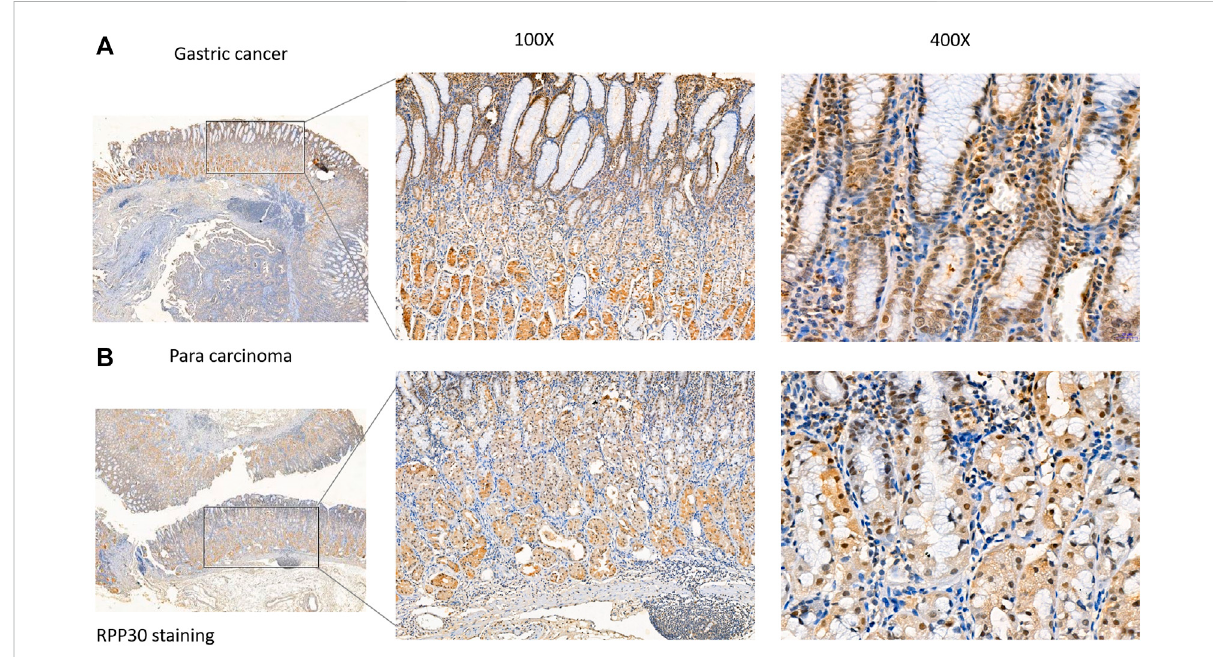
FIGURE 8 RPP30proteinexpressioninGCandpara-canceroustissuesassessedviaimmunohistochemicalstaining. (A) RPP30expressionwasfoundinGC specimens, especially in the nucleus of the glandular epithelium. (B) RPP30 protein expression was negative in para-cancerous